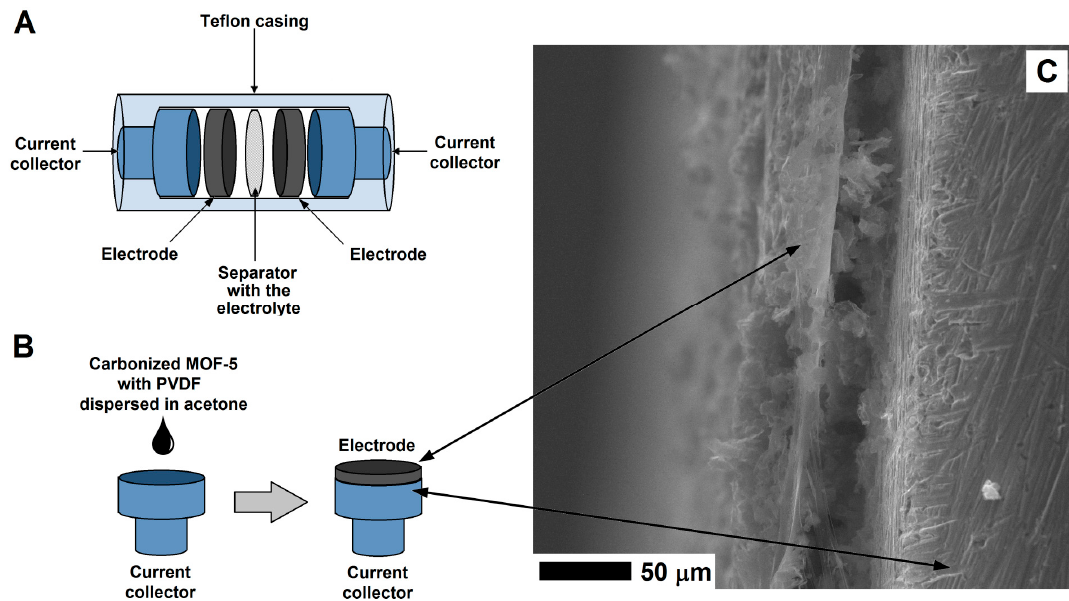
Figure 2. The structure of supercapacitor ( A ) and electrode preparation ( B ) with the SEM image of the electrode on the surface of the current collector ( C ).